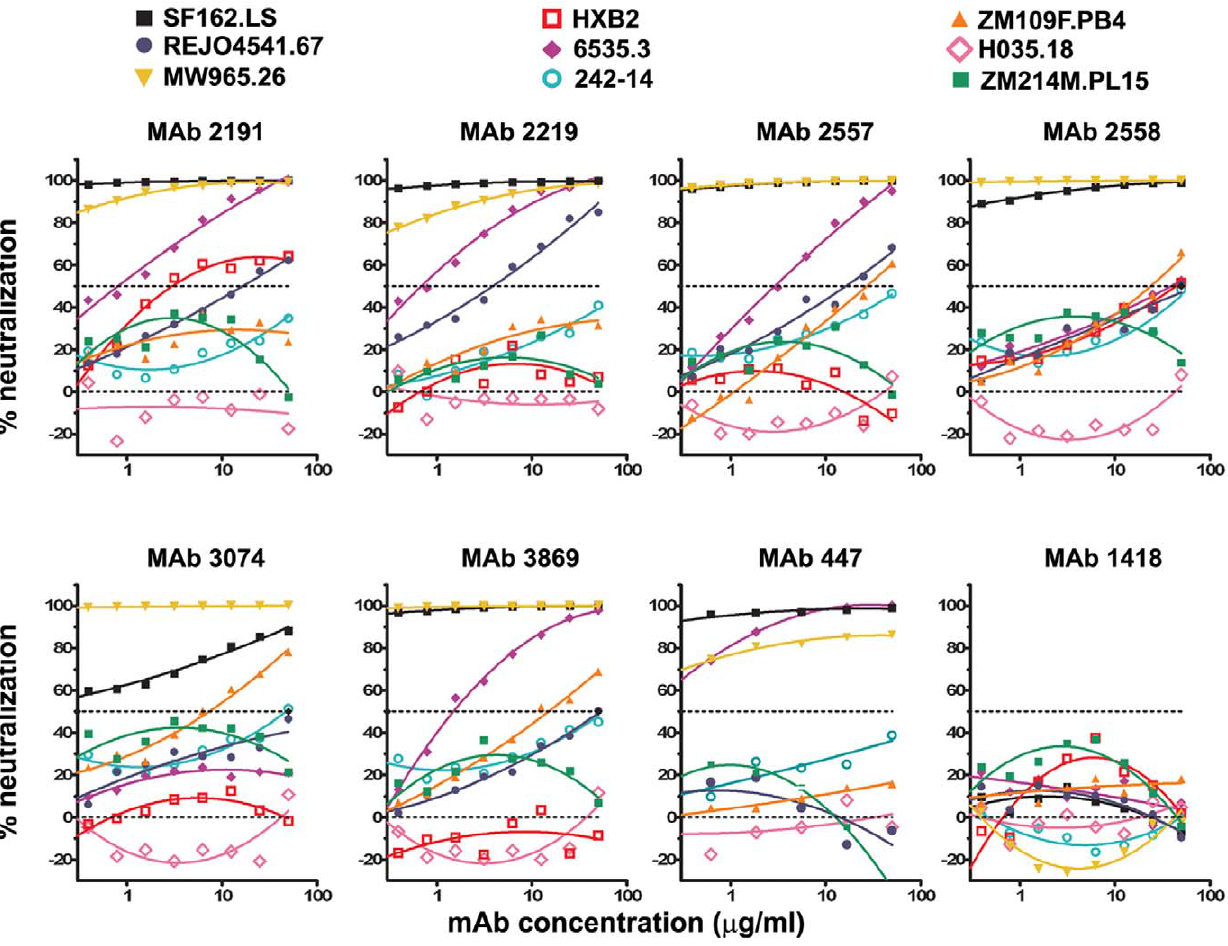
Figure 5. Neutralization curves of anti-V3 mAbs against representative HIV-1 psVs tested using the TZM.bl target cell line. Seven anti-V3 mAbs were tested against HIV-1 psVs in the TZM.bl experiment. The titration curves observed against nine selected viruses are shown. The background neutralization observed with the irrelevant control mAb 860 is also shown for comparison. Curve fitting was performed using the polynomial regression (quadratic) model described in Materials and Methods. Fifty percent neutralization is denoted by the dashed line.